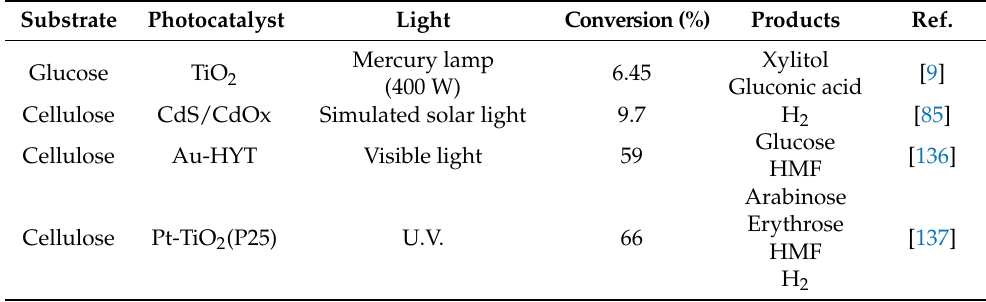
Table 3. The photocatalytic conversion of cellulose and its derivatives using four different